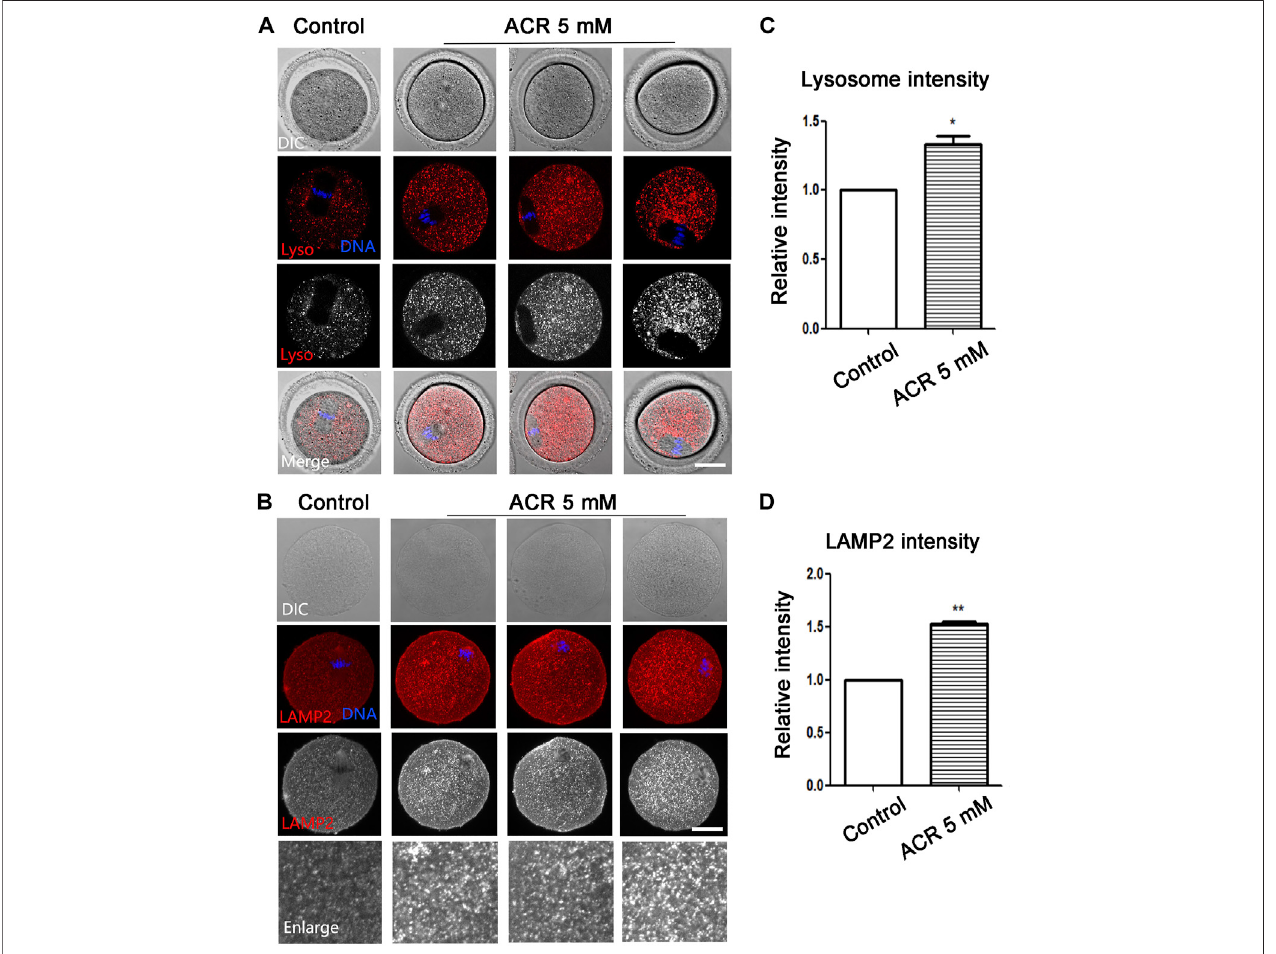
FIGURE 5 | ACR causes the expression of lysosomes in mouse oocytes. (A) The typical fl uorescence picture of lysosomes after ACR treatment. * p < 0.05. Red, Lyso-Tracker; blue, DNA.Bar=30 μ m. (B) Thetypical fl uorescencepictureofLAMP2after ACRtreatment. Red, LAMP2;blue, DNA. Bar=30 μ m. (C) The fl uorescence intensity of lysosomes after ACR exposure was signi fi cantly higher than that of the control group. *, p < 0.05. (D) Compared with the control group, the fl uorescence intensity of LAMP2 in oocytes decreased after ACR exposure. ** p < 0.01.